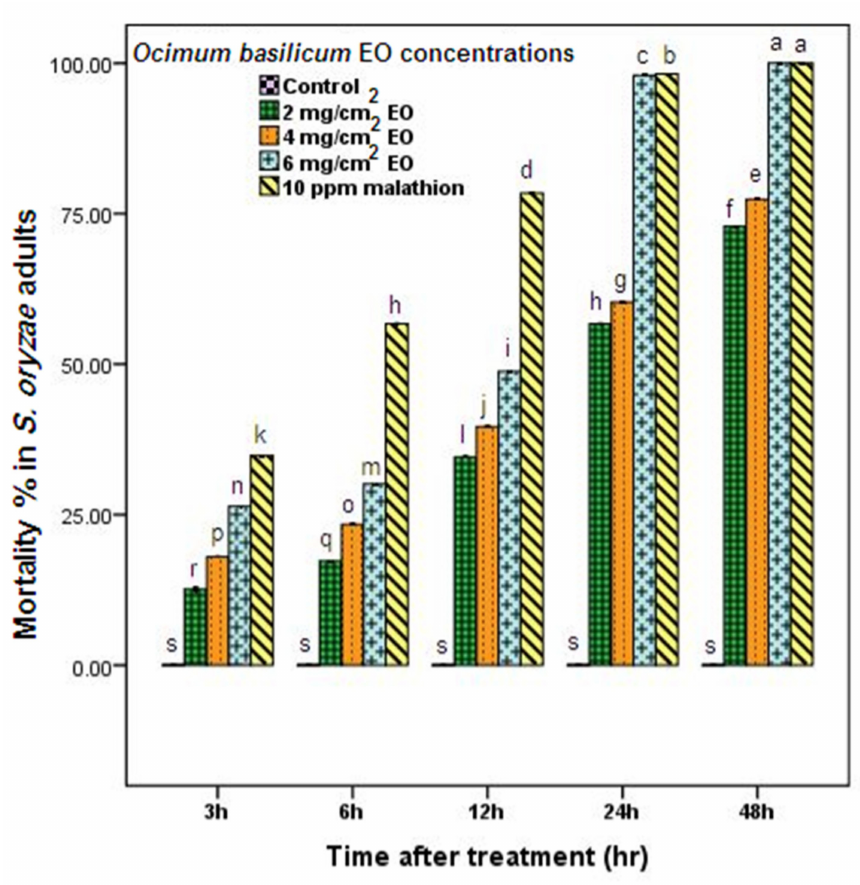
Figure 1. Impact of different concentrations (2, 4 and 6 mg/cm 2 ) from O. basilicum EOs on mortality of S. oryzae adults at 3, 6, 12, 24, and 48 h exposure times (mean ± SD) compared with standard chemical pesticide (10 ppm malathion). Different letters indicate significant differences between different treatments at p < 0.05; LSD =